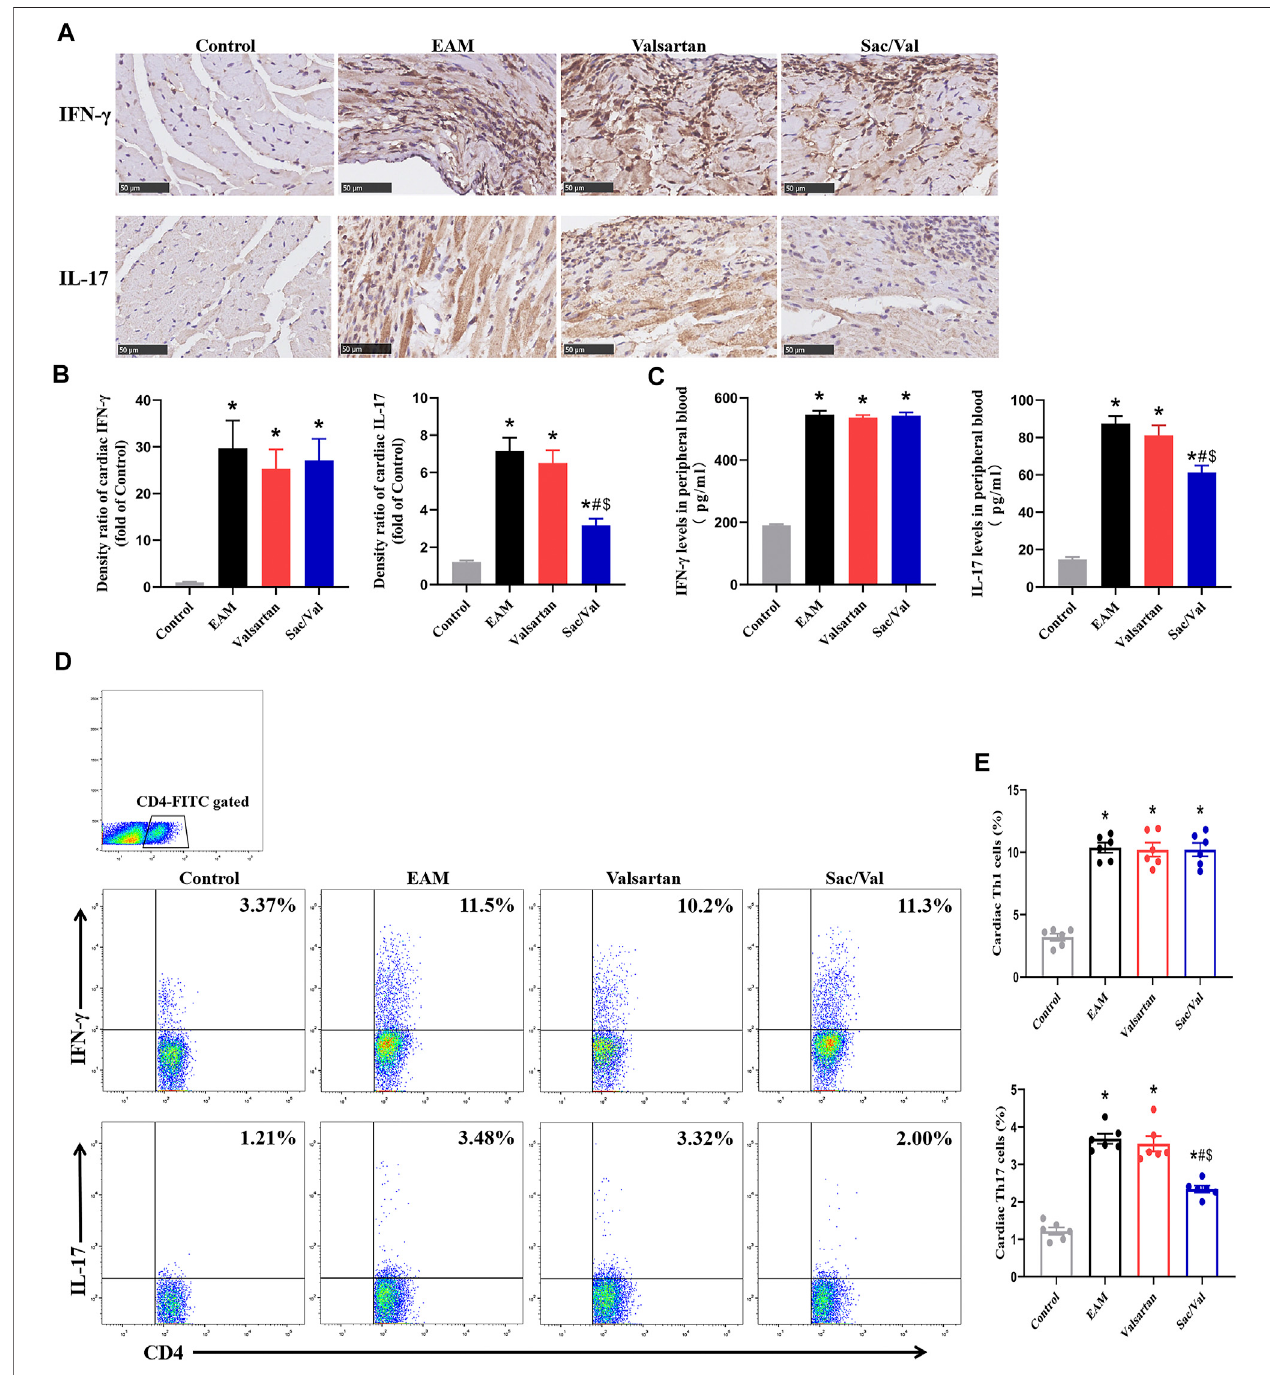
FIGURE 3 | Sac/Val inhibited the differentiation of Th17 cells in myocardial tissue. (A) Representative IHC images of cardiac IFN- γ and IL-17 (magni fi cation × 400). (B) SemiquantitativeanalysisoftheIHCresults. (C) LevelsofperipheralbloodIFN- γ andIL-17ineachtreatmentgroup. (D) Representative fl owcytometryimagesofTh1 (IFN- γ + ) and Th17 (IL-17 + ) cells gated on CD4 + T cells. (E) Statistical analysis of the fl ow cytometry results. All experiments had six mice per group and data were expressed as means ± SEM and analysed by one-way ANOVA. * p < 0.05 versus Control group; # p < 0.05 vs. EAM group; $ p < 0.05 vs. Valsartan